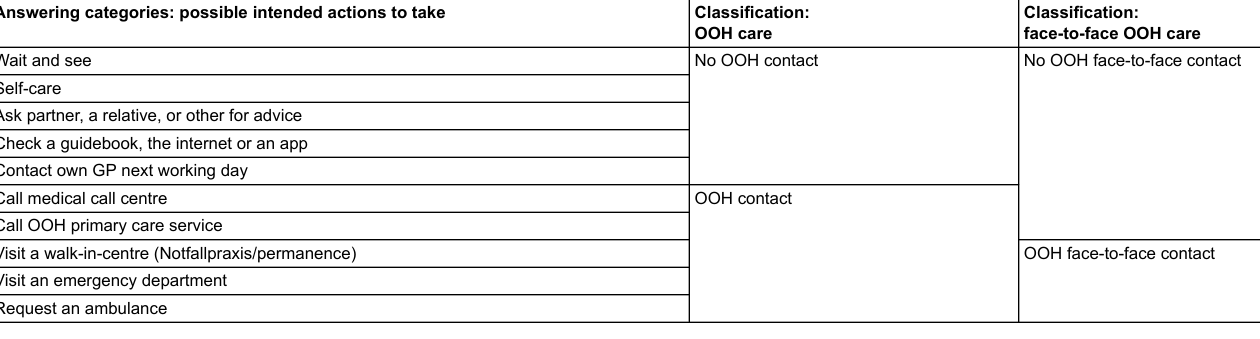
Table 2: Classification of intended out-of-hours (OOH) care. Answering categories: possible intended actions to